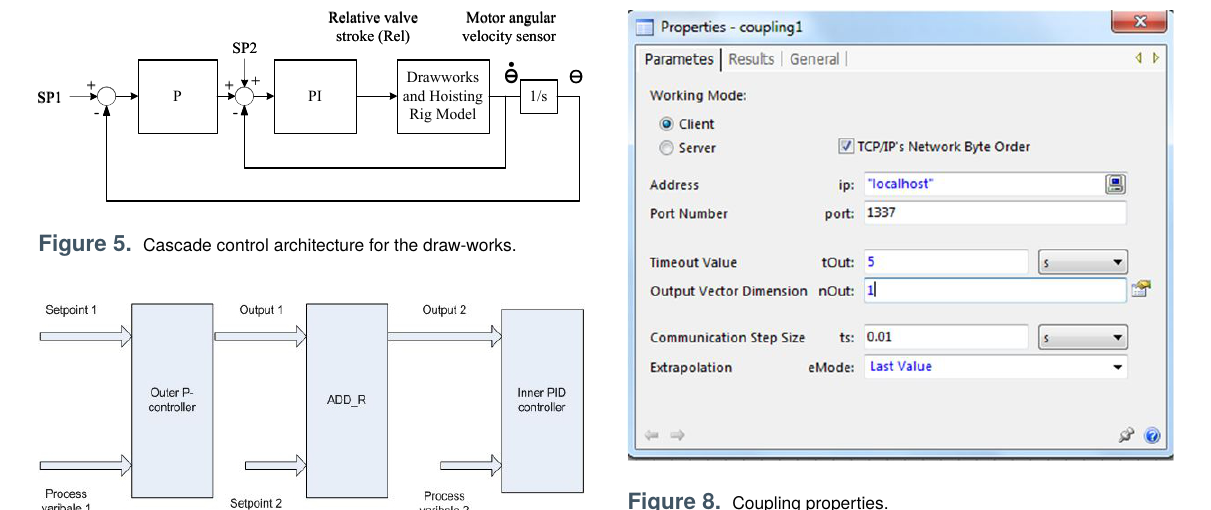
Fig. 6 Setup of cascade controller in PLC